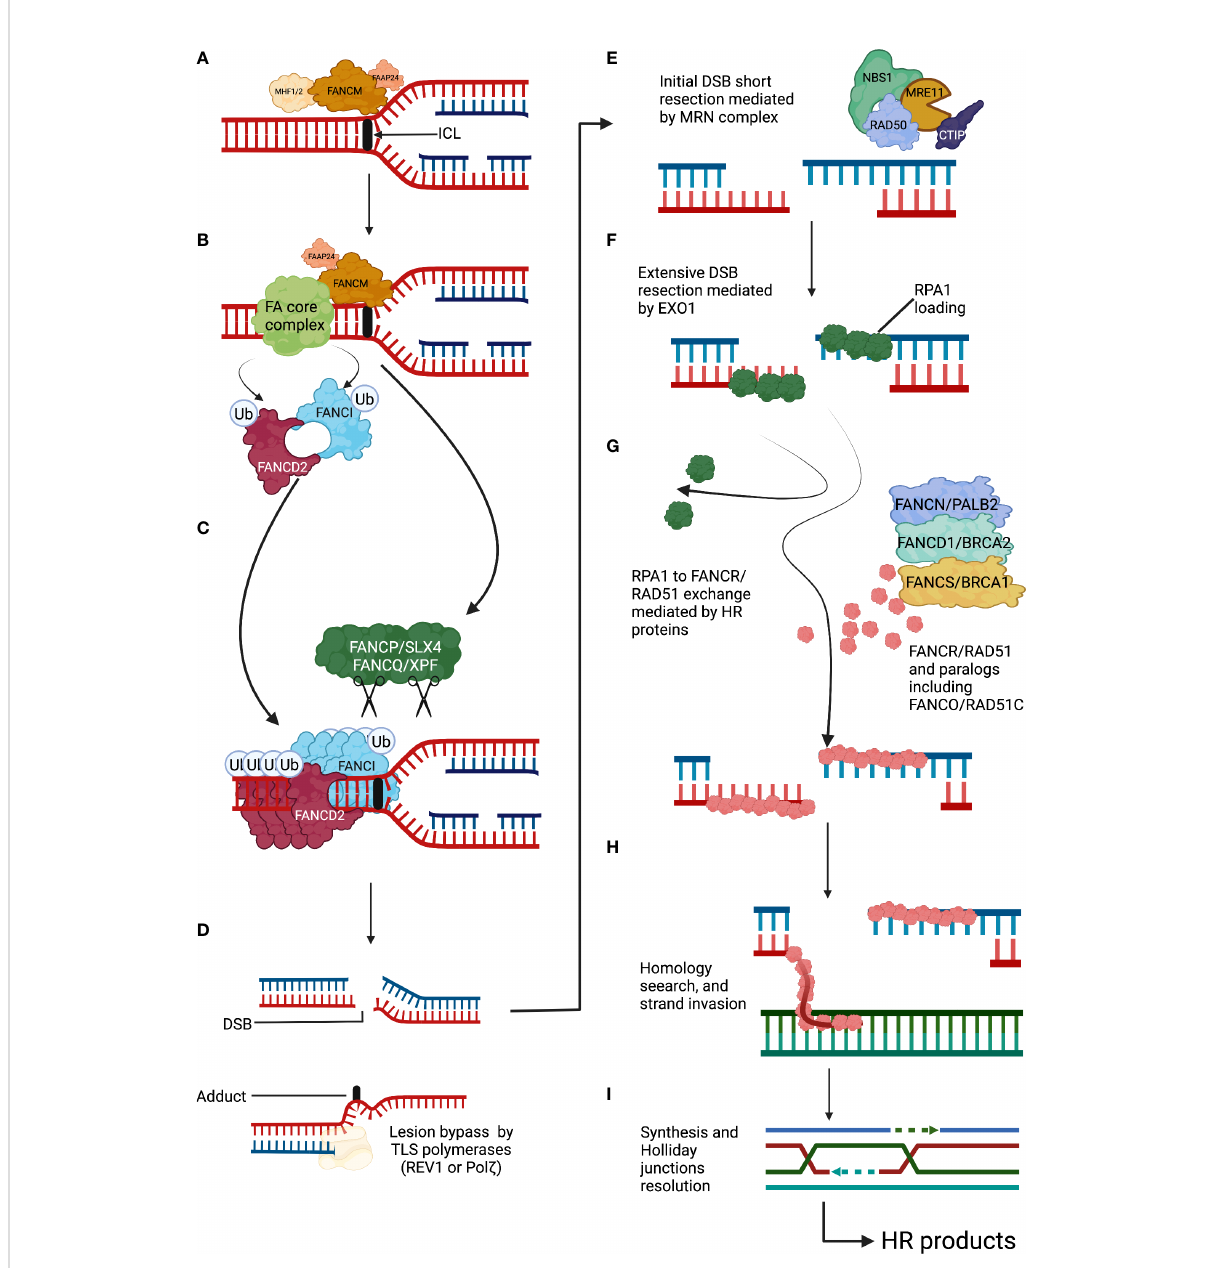
FIGURE 1 The Fanconi anemia pathway detects and repairs DNA interstrand cross-links. (A) An ICL covalently holds together the two complementary DNA strands. ICLs arrest the progression of the replication fork and are recognized by FANCM and its associated proteins. (B) The FANCM anchor complex recruits the FA core complex to the ICL site. The FA core complex in turn ubiquitylates the FANCD2-I complex. (C) Ubiquitylated FANCD2-I complex forms a fi lamentous array that clamps the stalled DNA replication fork and protects it from nucleolytic degradation. The FANCP/SLX4 is a DNA endonucleases toolbox that will unhook the ICL site by cleaving the surrounding DNA. (D) After ICLs unhooking two DNA repair intermediates appear, a DSB that will be repaired by the downstream FA/BRCA proteins using HR and a DNA adduct that will be processed with the help of TLS DNA polymerases. (E) The DSB will initially undergo a short resection mediated by exonuclease activity of the MRN complex. (F) Extensive DSB resection will be performed by the EXO1 endonuclease, and the produced DNA overhang will be covered and protected by RPA1 protein subunits. (G) The HR mechanism will start with the exchange of RPA1 by subunits of the recombinase RAD51. This exchange will be assisted by homologous recombination mediators including FANC/PALB2, FANCD1/BRCA2, and FANCS/BRCA1. (H) RAD51- coated DNA overhangs will function as recombinase fi laments that will search for sequence homology. (I) Strand invasion will be followed by sequence detection, copy and synthesis of the sequence of interest, Holliday junctions resolution, and ligation of the phosphate DNA backbone. DSBs, double-strand breaks; FA, Fanconi anemia; HR, homologous recombination; ICLs, interstrand cross-links; TLS, translesion